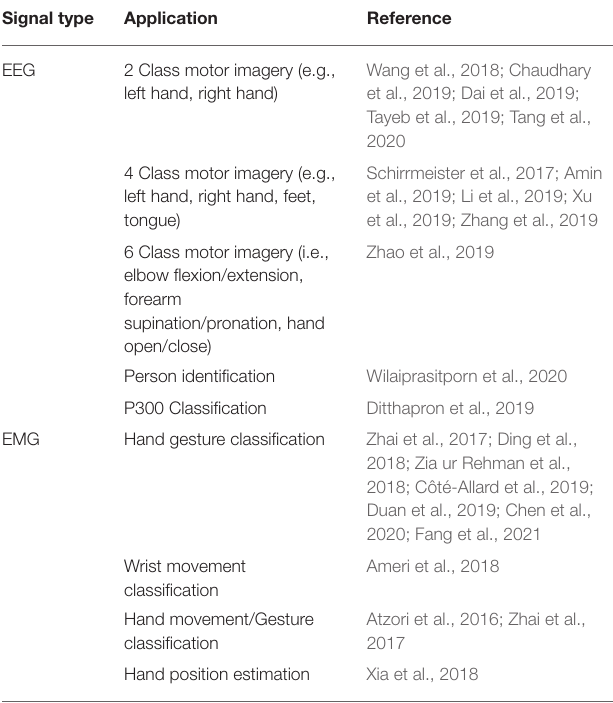
TABLE 1 | A summary of select literature examples using CNN models with EEG or EMG signals. Signal